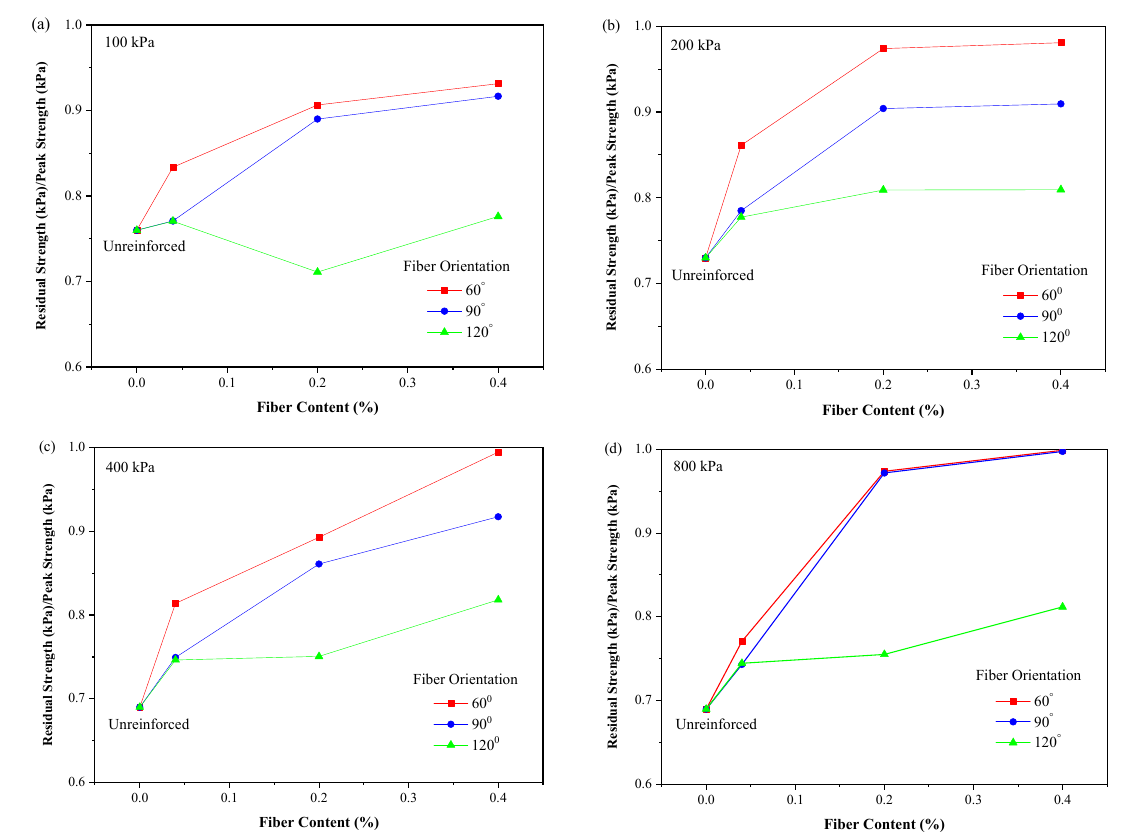
Figure 5. The ratio of residual to peak strength of sand specimens under normal pressures of ( a ) 100, ( b ) 200, ( c ) 400, and ( d ) 800 kPa.